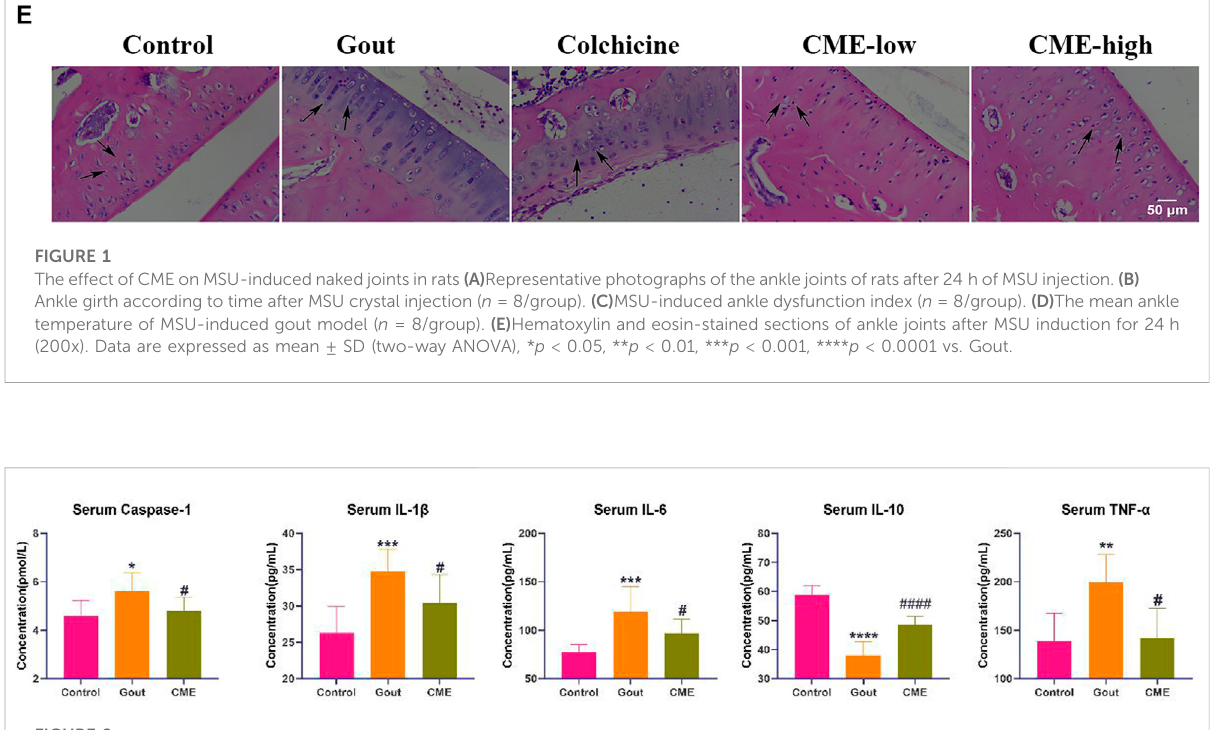
FIGURE 2 Analysis of the effect of CME on the levels of gout in fl ammatory factors by ELISA ( n = 8/group). Data are expressed as mean ± SD (one-way ANOVA), * p < 0.05, ** p < 0.01, *** p < 0.001, **** p < 0.0001 vs. Control; # p < 0.05, ## p < 0.01, ### p < 0.001, #### p < 0.0001 vs.